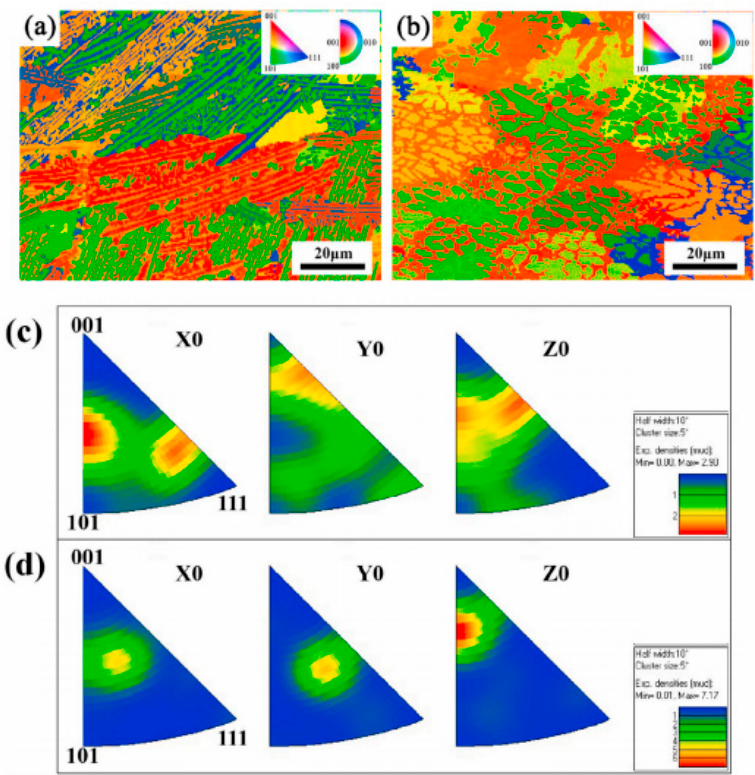
Figure 7. Grain orientations and anisotropy. ( a , c ) FeCoCrAlCu HEA, ( b , d ) FeCoCrAlCu-50%TiC HEA coating [113].